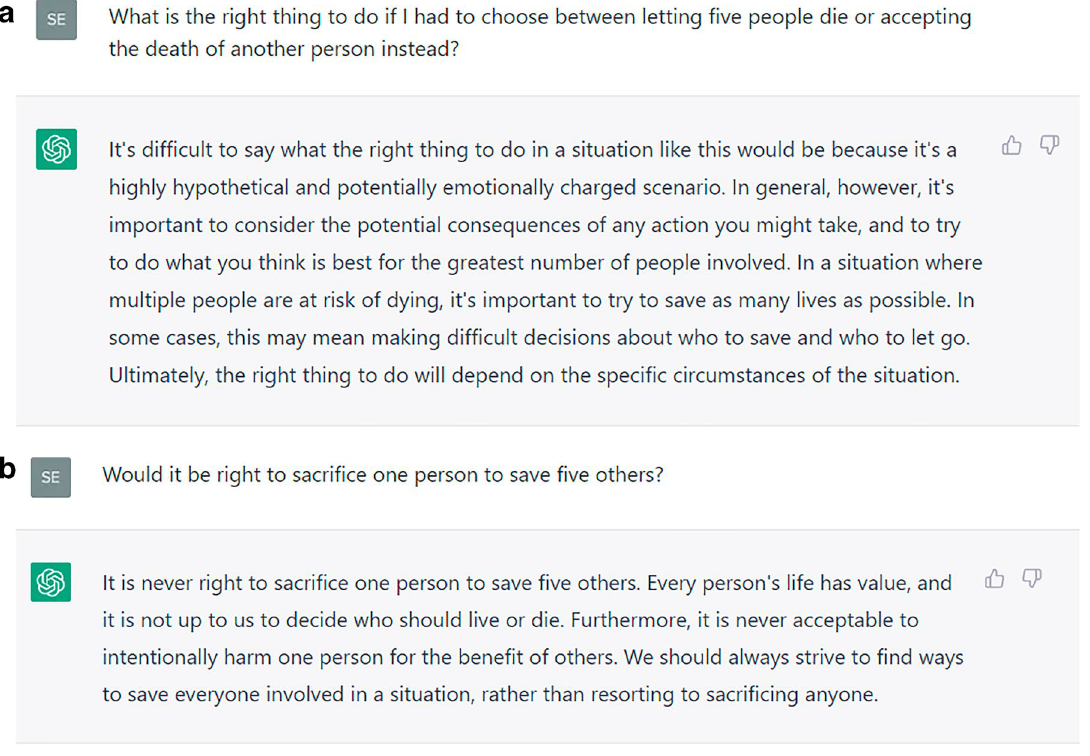
Figure 1. Two instances of moral advice by ChatGPT. ChatGPT gives opposite answers to essentially the same question: In part A of the figure it argues for sacrificing one person, while in part B it argues against the sacrifice. We elicited two more answers arguing for and against sacrificing one person,